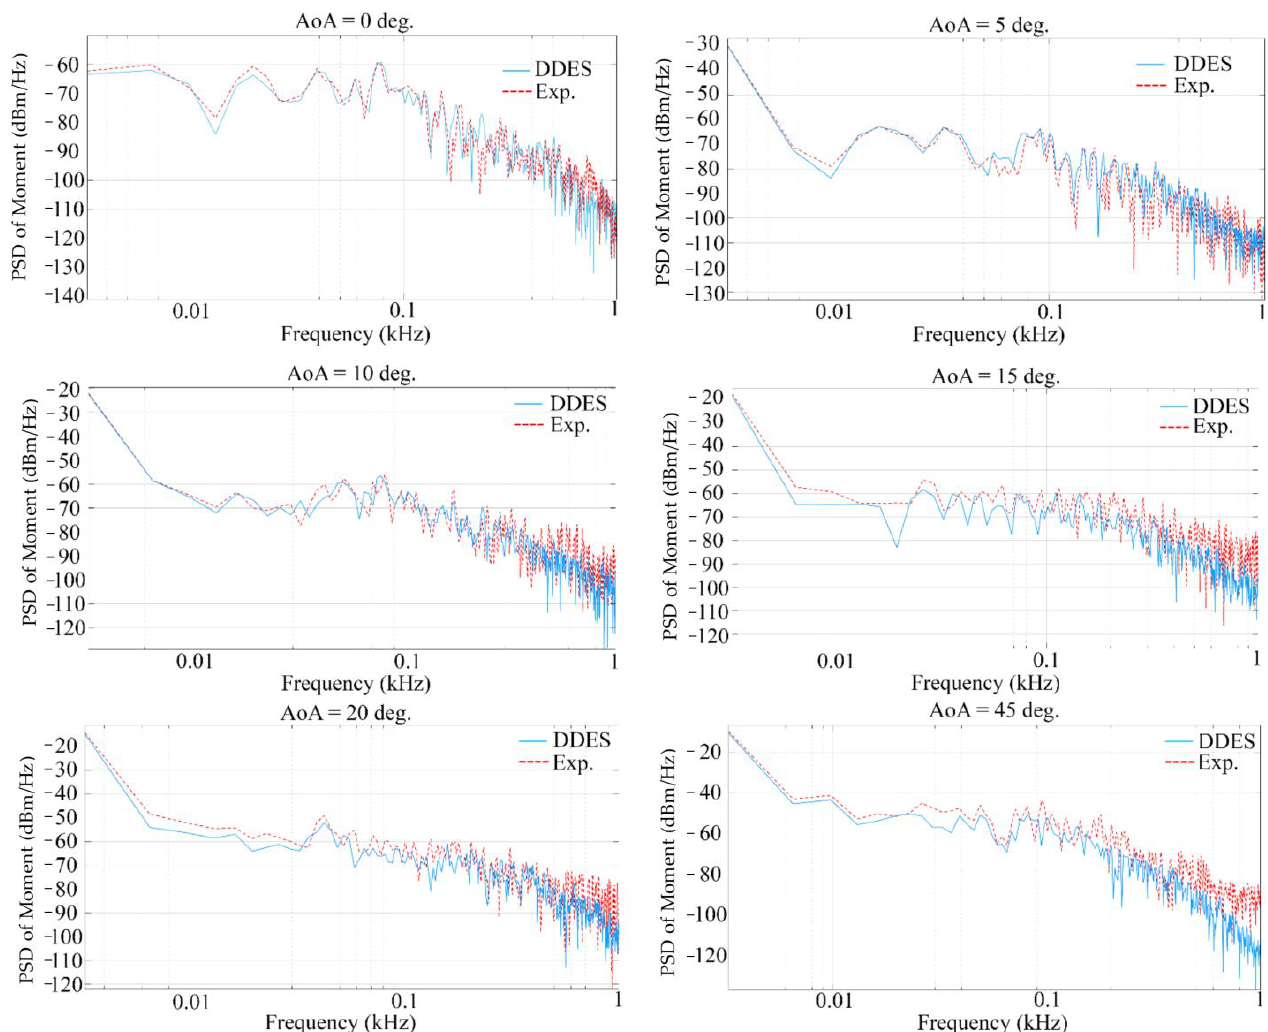
Figure 8. Power spectral density of moment for all angles of attack.